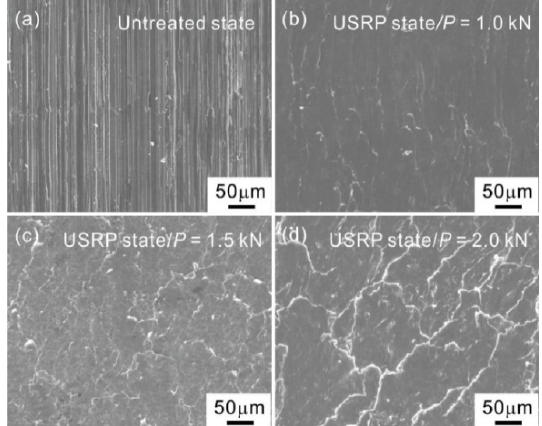
Figure 2. Surface morphologies in ( a ) the untreated specimen and ( b )–( d ) the USRP-treated specimens with a static load P of 1.0 kN, 1.5 kN and 2.0 kN, respectively.